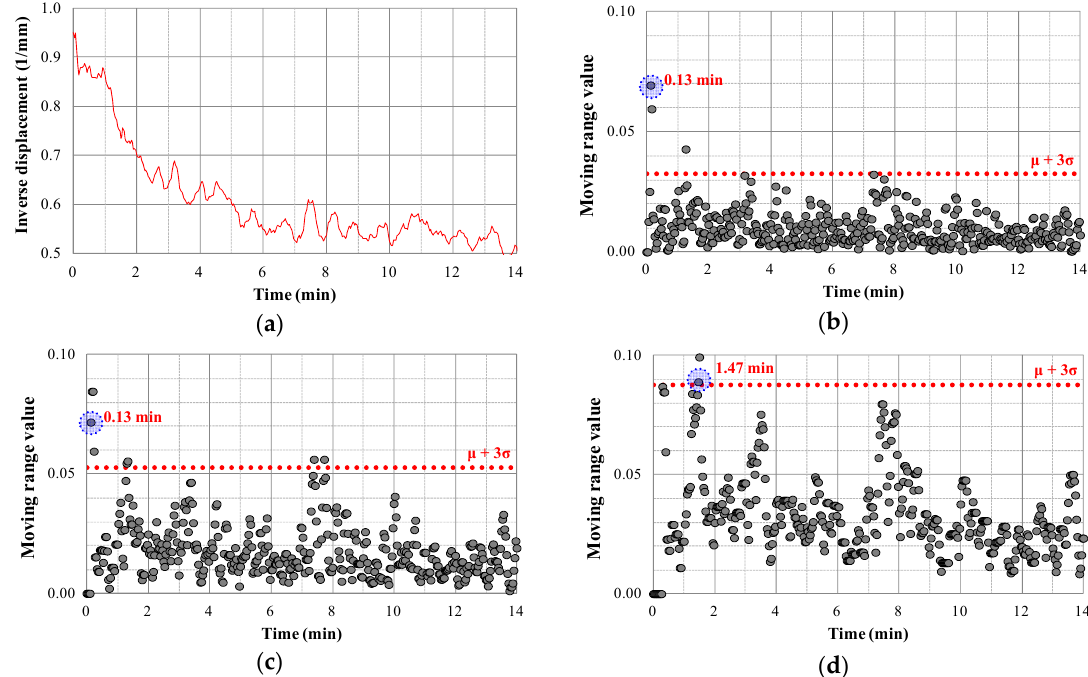
Figure 13. x–MR control chart method for displacement data of case 2 (moving average = 10 points): ( a ) Inverse displacement (moving average = 10 points); ( b ) Moving range (K = 3); ( c ) Moving range (K = 5); ( d ) Moving range (K = 10).